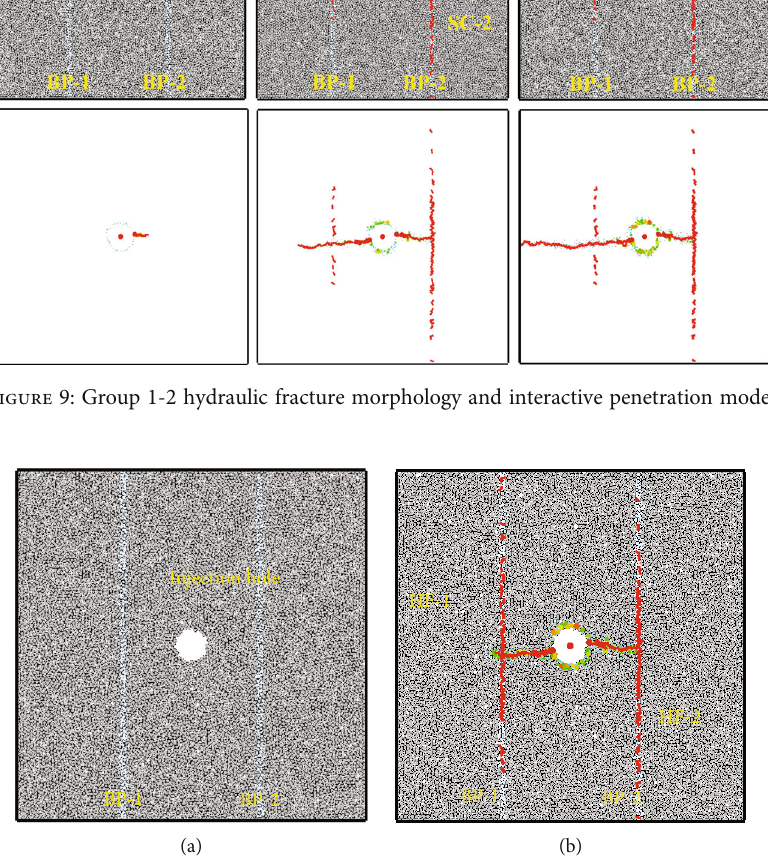
Figure 10: Group 1-3 hydraulic fracture test: (a) test block before hydraulic fracturing; (b) test block after hydraulic fracturing.